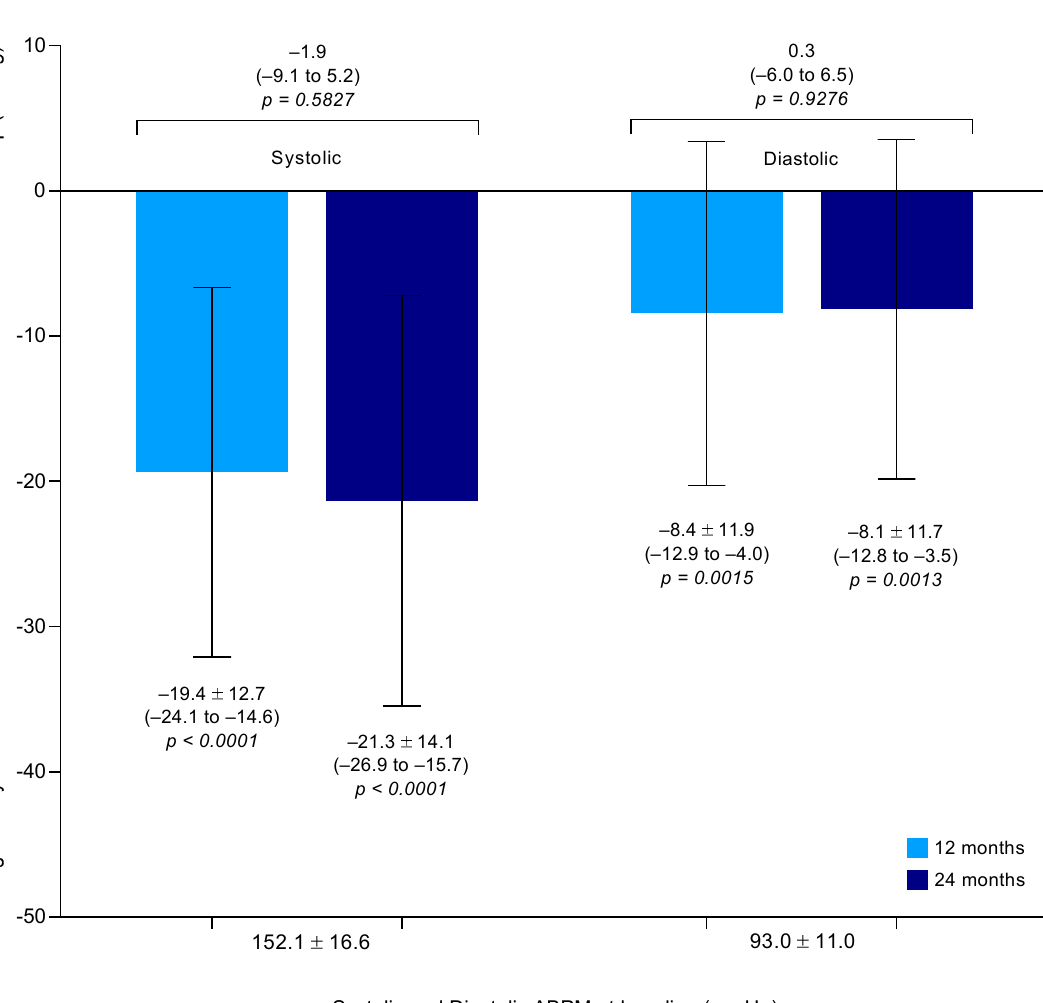
Figure 2. Changes at 12 and 24 months of follow-up in ambulatory systolic blood pressure and diastolic blood pressure post-RDN. Data are mean ± SD (95% CI). ABPM = 24-h ambulatory blood pressure monitoring.